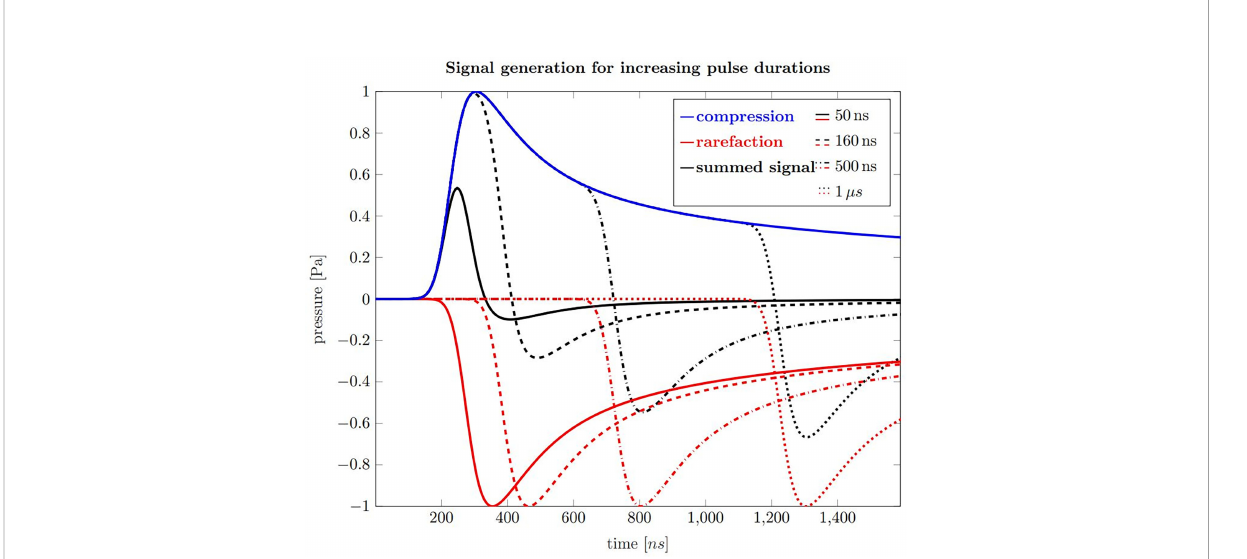
FIGURE 3 Ionoacoustic signal generation by a rectangular, 20 MeV proton beam as detected by an ideal point sensor. Blue is the compression curve and red are rarefaction curves for pulse durations of 50 ns (solid), 160 ns (dashed), 500 ns (dash-dotted) and 1 µs (dotted). The black curves show the resulting pressure distributions, which arises from the sum of the compression and the corresponding rarefaction